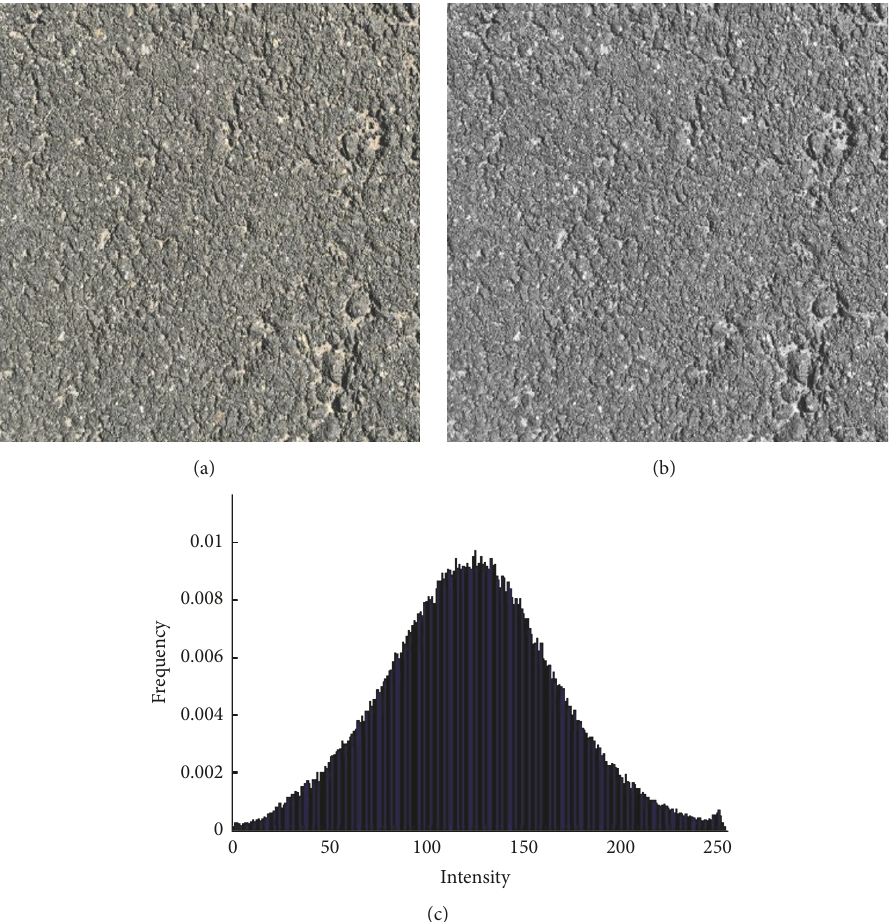
Figure 2: (a) Color asphalt Image, (b) grayscale asphalt image, and (c) frequency histogram of grayscale image.